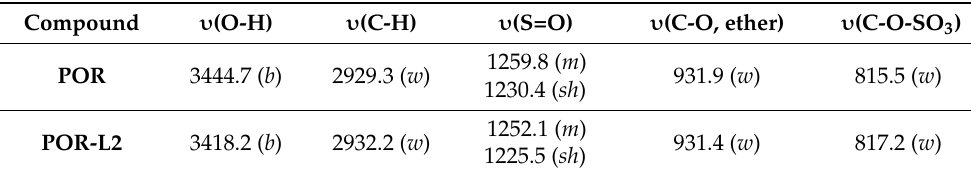
Figure 3. Close-up of the FTIR spectra obtained for POR and POR-L2 in KBr pellet. Table 1. Selected IR bands (in cm − 1 ) for POR and POR-L2